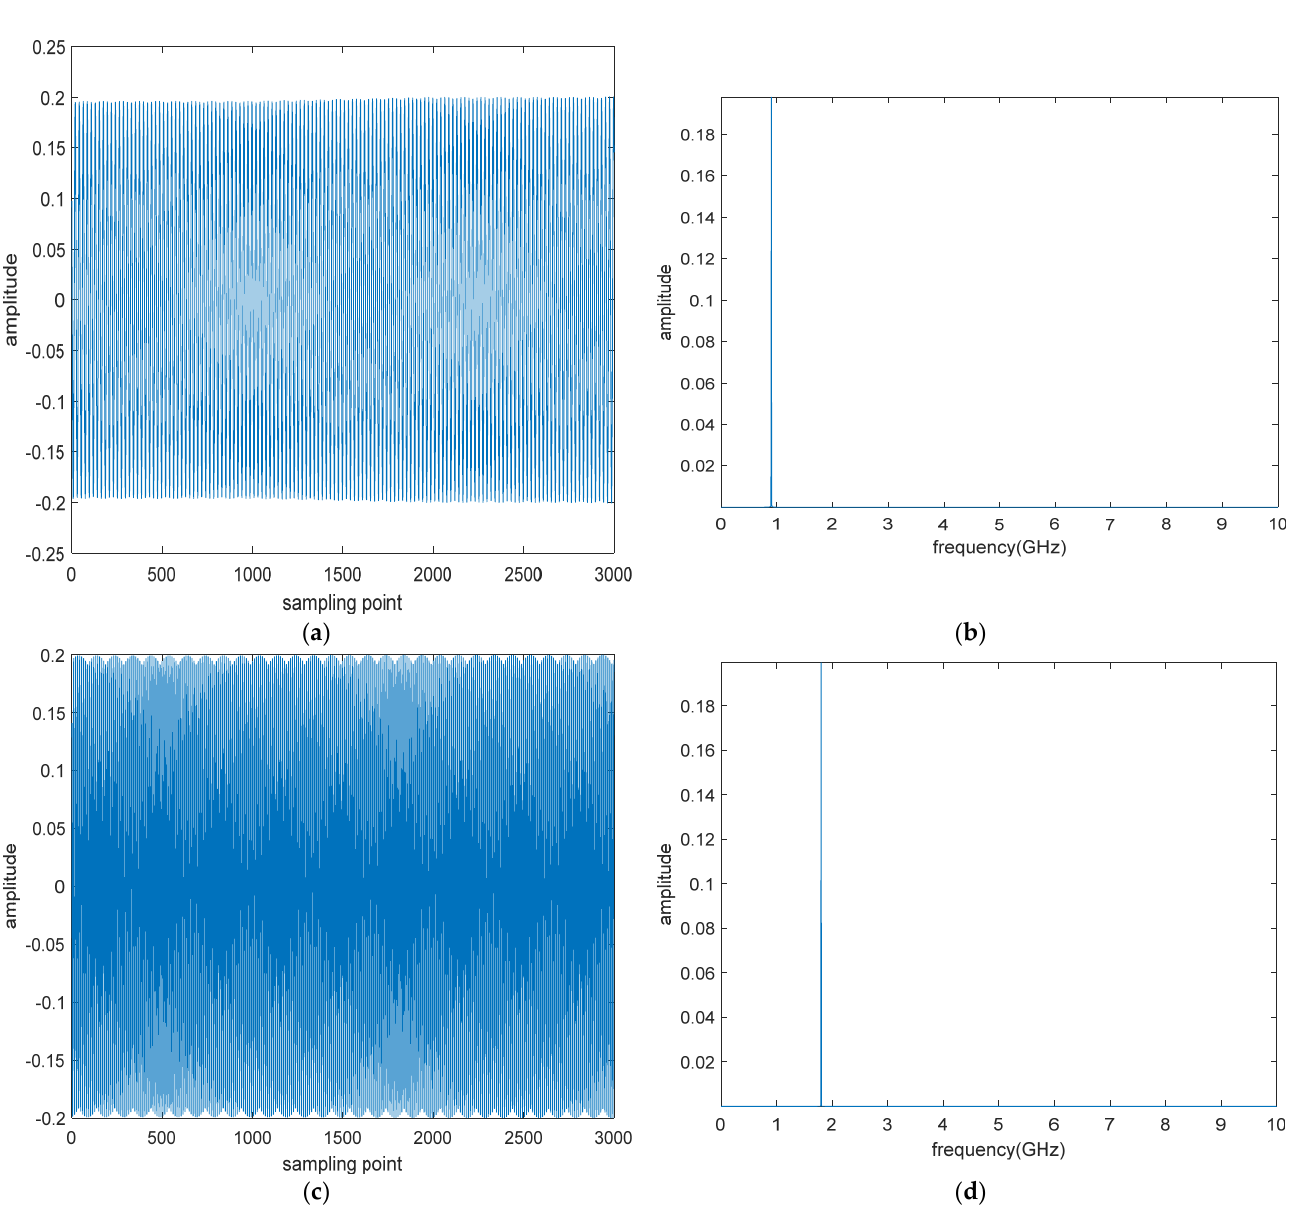
Figure 7. The refined synthetic signals. ( a ) srec1 in time domain, ( b ) srec1 in frequency domain, ( c ) srec2 in time domain, and ( d ) srec2 in frequency domain.